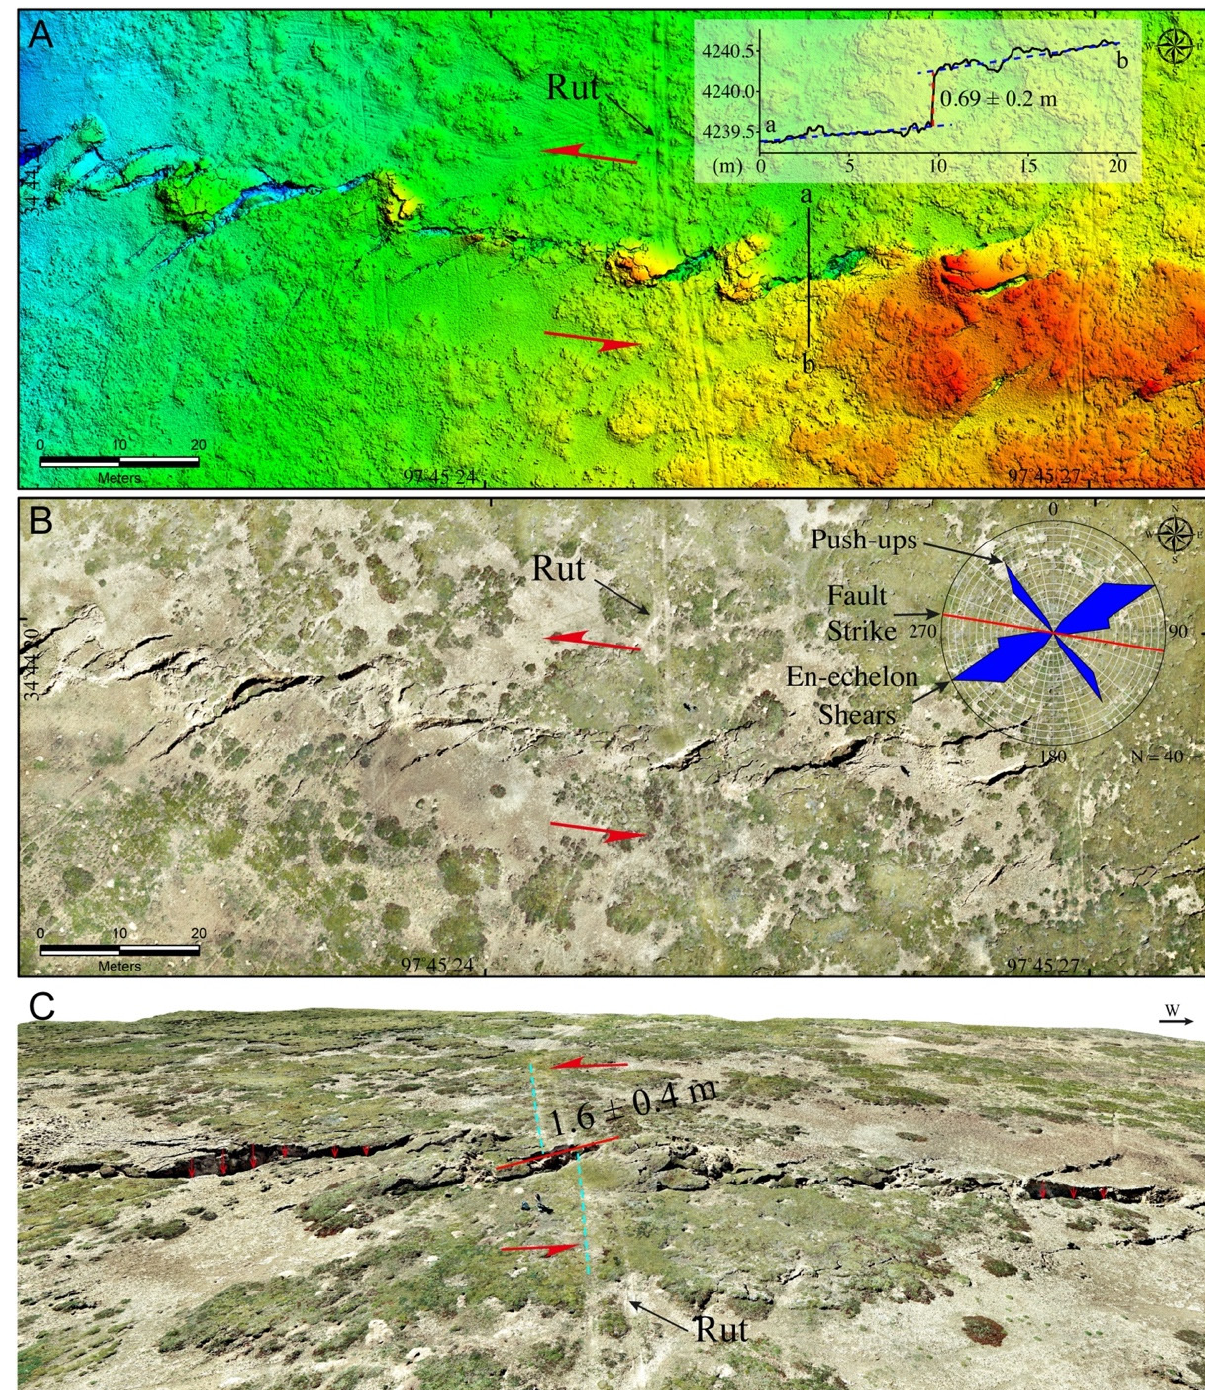
Figure 6. Offsets and fracture distribution statistics. ( A ) DEM of the surface rupture. South side of the fault was uplifted, and the vertical offset is 0.69 m. ( B ) Orthophoto of the area shown in panel ( A ). En-echelon shears and push-ups are major structures. ( C ) 3D visualization of the surface rupture. The offset along the shear strike is 1.6 m, the included angle θ between shear strike and fault strike is 37°, then the offset along the fault strike equals to 1.6/cos (37°), which is about 2 ± 0.4 m.